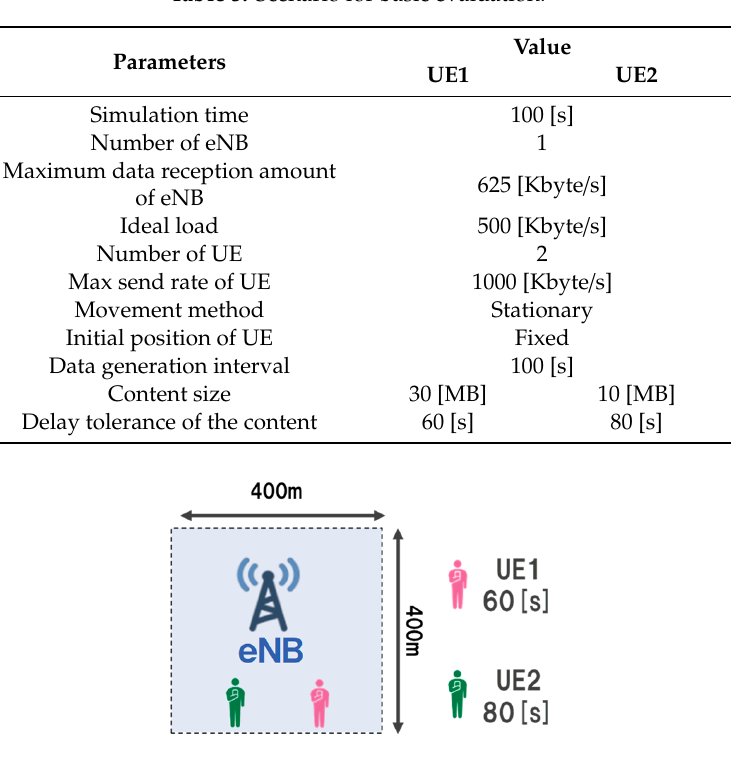
Table 3. Scenario for basic evaluation.